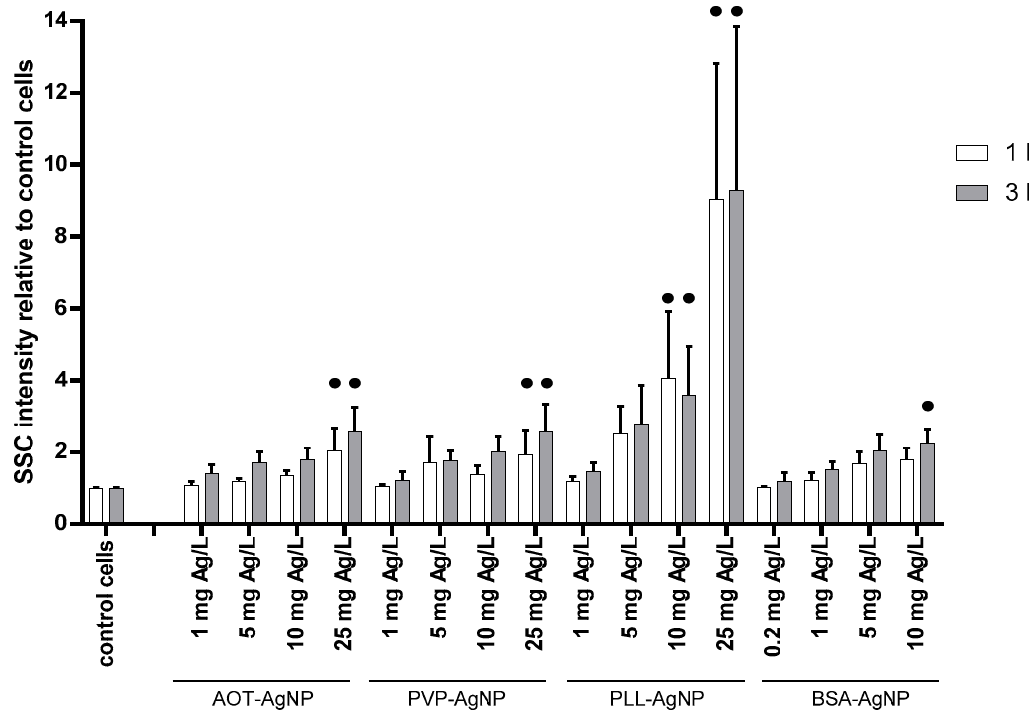
Figure 4. Uptake of AOT-, PVP-, PLL- and BSA-coated AgNPs by hPBMC cells analysed by the flow cytometry. Cells were exposed to different concentrations of AgNPs, given in mg Ag/L, for 1 (white columns) and 3 h (grey columns). Control cells were cultivated in AgNPs-free exposure media (negative controls). The percentage of relative uptake, calculated as percentages of the increase of the side scattered light of the laser beam (SSC) relative to control cells, is expressed as the mean of six independent experiments including SD as error bars. Significant differences between treated and control cells are marked with dots (•) at p > 0.05.